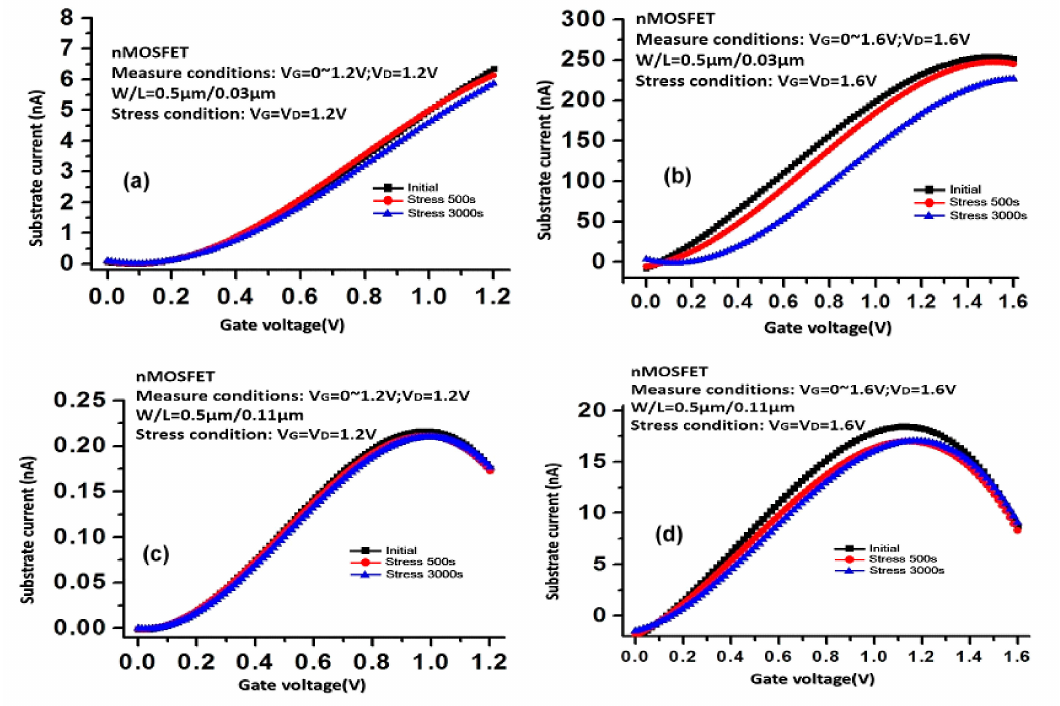
Figure 5. In channel-hot-carrier (CHC) test conditions, the I SUB at: ( a ) W / L = 0.5 / 0.03 µ m / µ m, stressed at V GS = V DS = 1.2 V, ( b ) W / L = 0.5 / 0.03 µ m / µ m, stressed at V GS = V DS = 1.6 V, ( c ) W / L = 0.5 / 0.11 µ m / µ m, stressed at V GS = V DS = 1.2 V, and ( d ) W / L = 0.5 / 0.11 µ m / µ m, stressed at V GS = V DS = 1.6